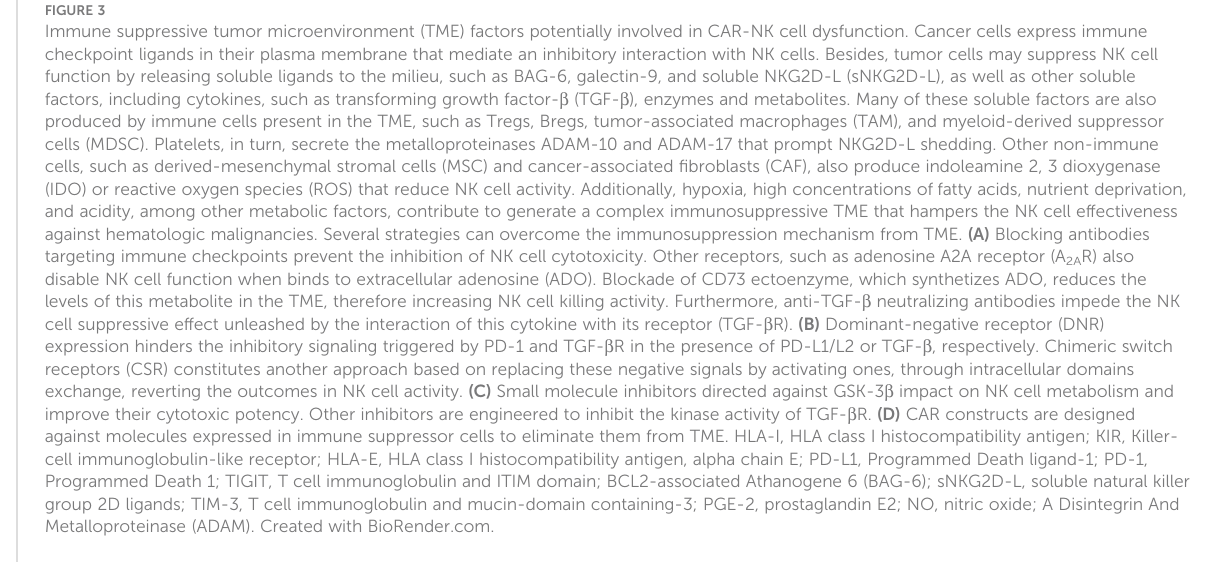
202). A functional threshold that controls the activatory or inhibitory NK cell function of this receptor has been proposed to explain this discrepancy. Meanwhile, TIGIT recognizes poliovirus receptor (PVR or CD155), Nectin-2 (CD112), or